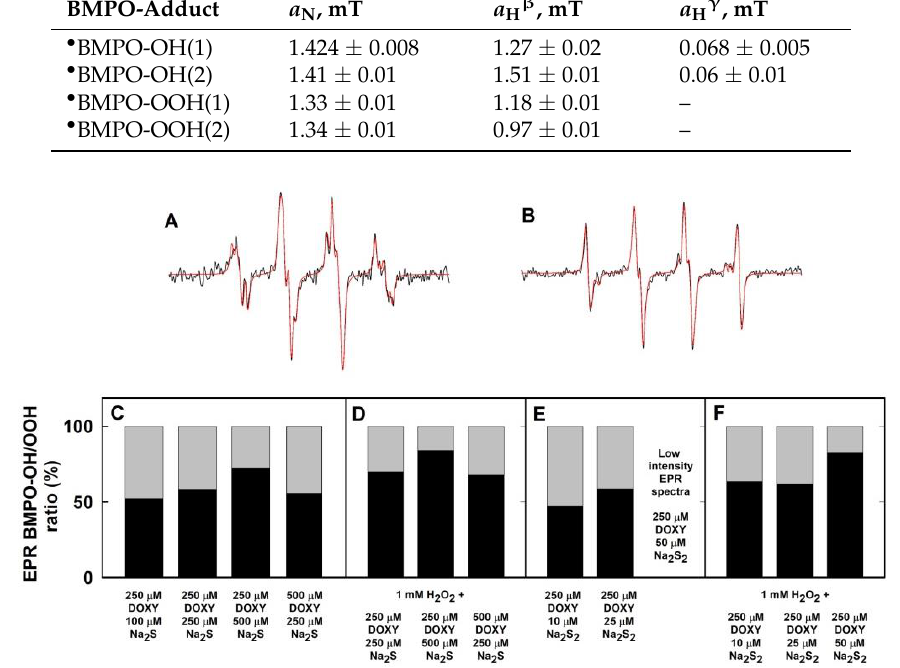
Figure 5. Simulation of the • BMPO-adducts EPR spectra. Representative experimental (black) and simulated (red) EPR spectra of the • BMPO-adducts for 250/250 µ M/ µ M DOXY/Na 2 S ( A ) and 1 mM H 2 O 2 with 250/500 µ M/ µ M DOXY/Na 2 S ( B ). Magnetic field sweep 8 mT. Ratio of integral EPR spectra